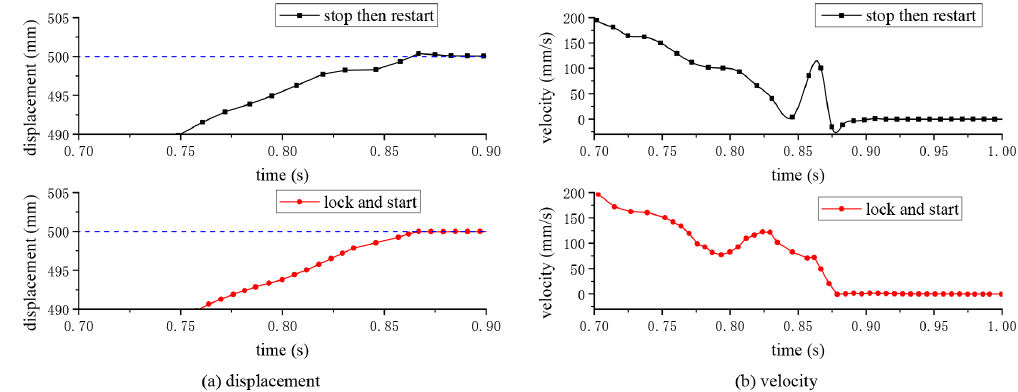
Figure 17. Comparison of the positioning test of 0–450mm with the strategies of lock and start and stop then restart.